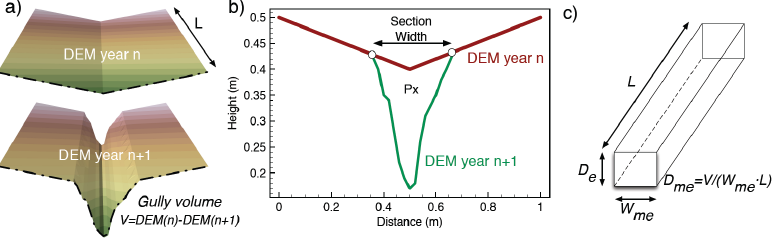
Figure 4. (a) Sketch of two separate digital elevation models of an artificial plot before (DEM year n ) and after (DEM year n + 1 ) a gully has been formed in the plot thalweg; (b) sketch of cross section area depicted at any point x along the longitudinal axis of the gully; (c) equivalent prismatic gully (EPG). See Sect. 3 for